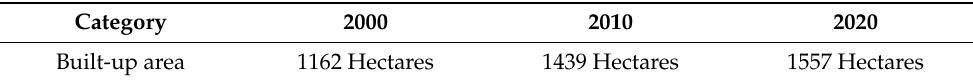
Table 4. The extent of built-up area in Batticaloa Municipality.